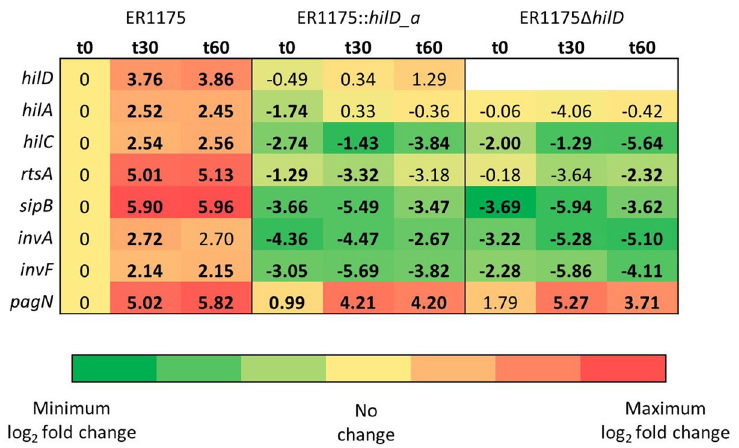
Figure 5. Gene expression during infection of human cells. Quantitative RT-PCR on ER1175 and its mutants during infection of human cells. The table reports the log2 fold-change values relative to ER1175-t0. Bold values are significantly different to ER1175-t0 (adjusted p-value < 0.05).